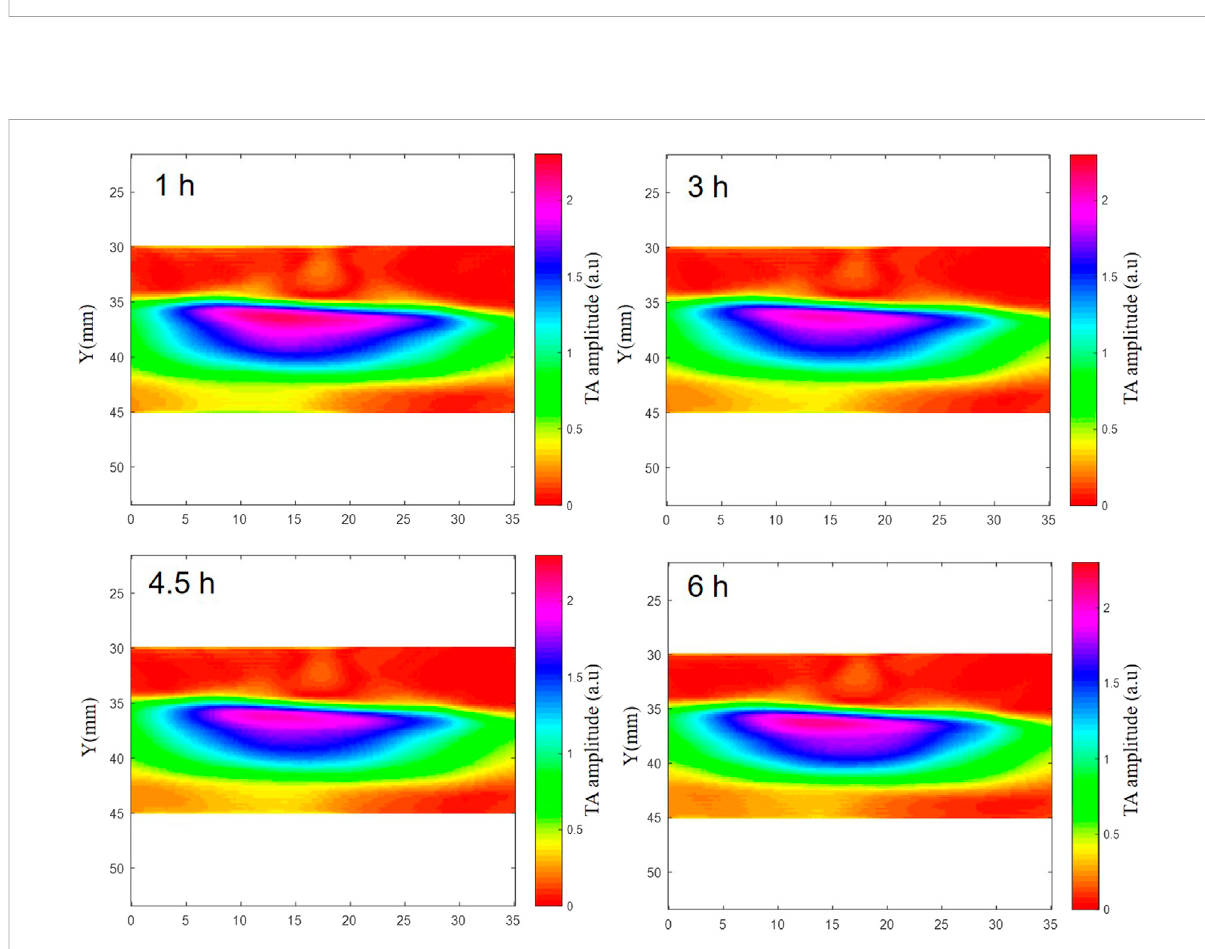
FIGURE 3 The TAI of fresh ex vivo porcine blood at 1 h, 2 h, 3 h, 4.5 h and 6 h. The results showed that there was no signi fi cant change in the thermoacoustic signals of fresh ex vivo porcine blood at 1 h, 2 h, 3 h, 4.5 h and 6